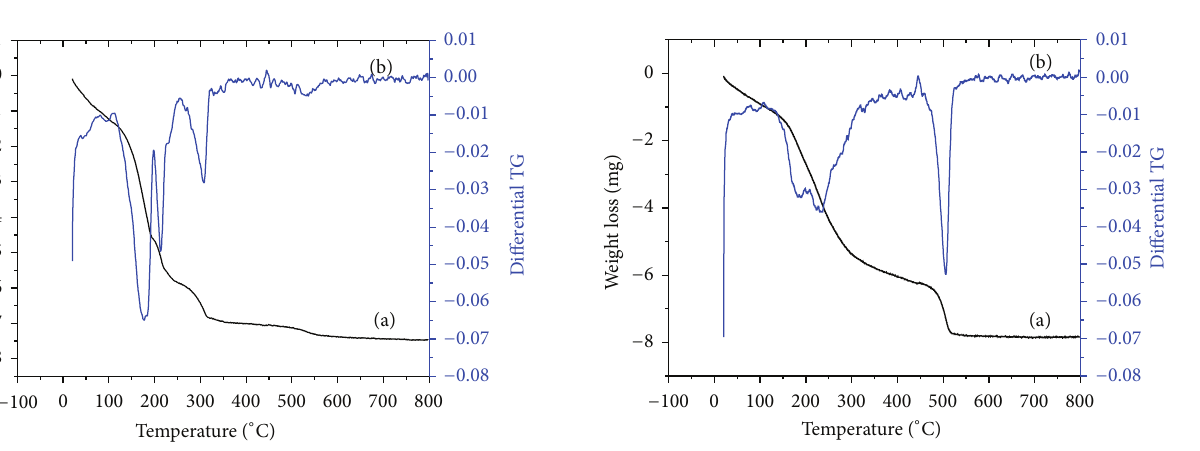
Figure 15: (a) TGA thermograms of KPDMU. (b) Differential plot of KPDMU.